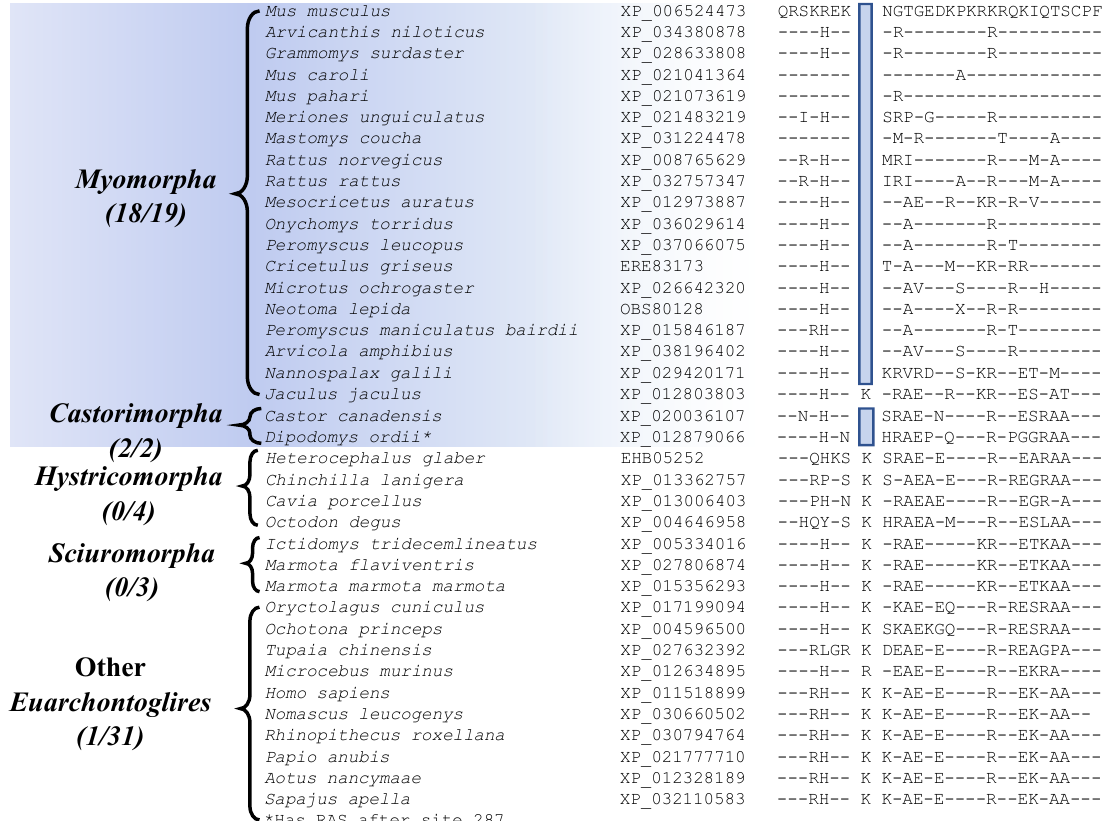
Figure 6. Partial sequence alignment for the protein ATP-dependent DNA helicase DDX11 isoform 1, showing a 1 amino acid deletion that is commonly shared by all Myomorpha and Castorimorpha species except the deep-branching Jaculus jaculus. Sequence information for another CSI that is commonly shared by species from these two suborders is provided in Figure